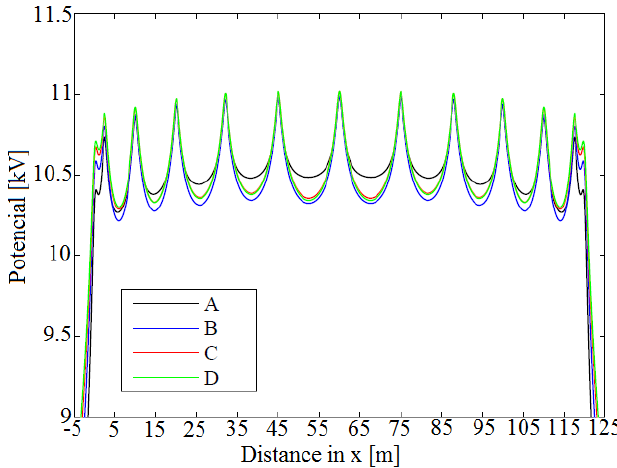
Fig. 8 Profiles on the soil surface, results obtained by the proposed